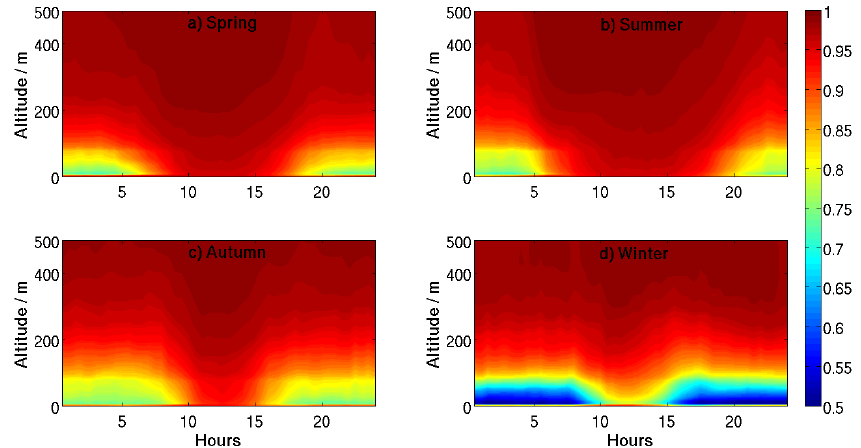
Fig. 10. Seasonal average values over the first 500m above the surface at SMEAR II for model simulations with the chemistry model from scenario B divided by scenario D (for the definition of the scenarios see Sect. 3.3). The colour bar gives the ratio as described in Eq. (5).